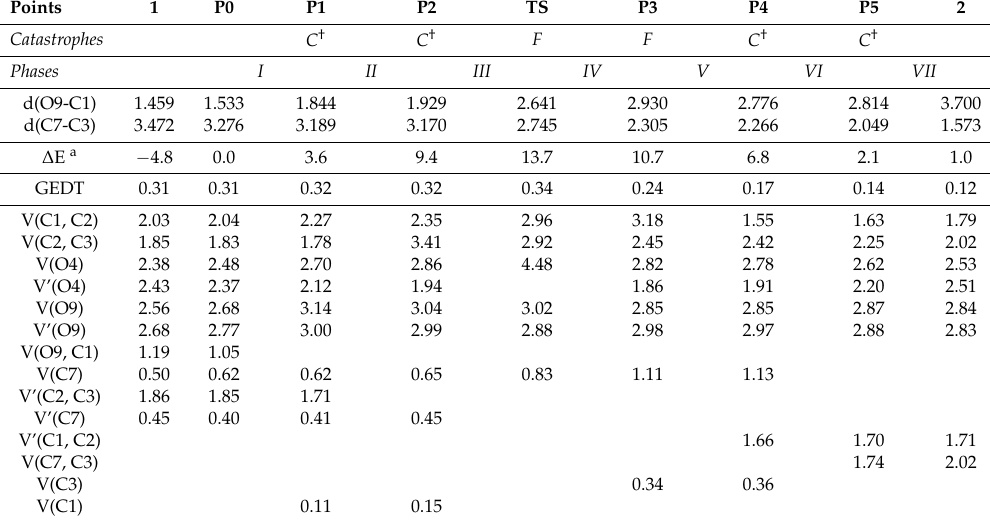
Table 1. ELF valence basin populations, distances of the breaking and forming bonds, and relative a electronic energies of the IRC points, P0 – P5 , defining the eight phases characterizing the rearrangement of the nitronic ester 1 to 5-chloro-5-nitro-7-oxo-bicyclo[2.2.1]-hept-2-ene 2 . The stationary points 1 , TS , and 2 are also included. Distances are given in angstroms, Å, electron populations in average number of electrons, e, relative energies in kcal · mol − 1 , and GEDT values in average number of electrons,